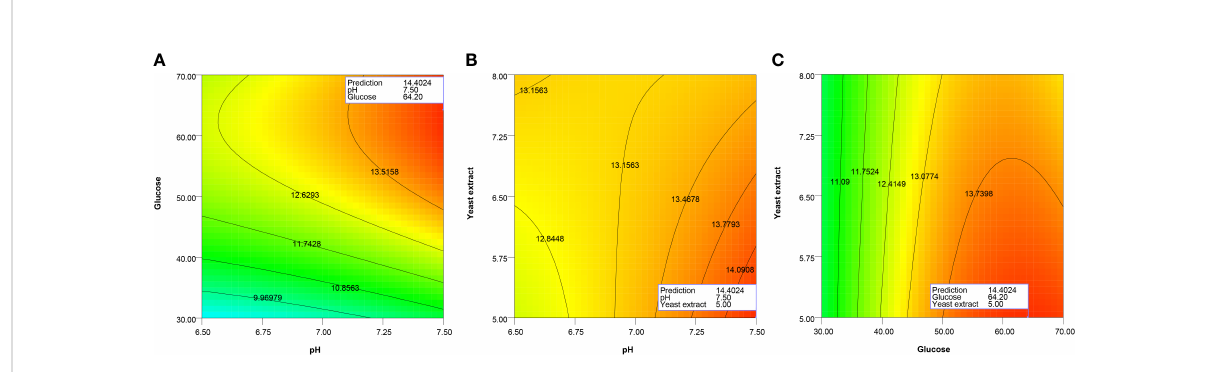
FIGURE 3 Contour plots showing interactions effects between initial pH and initial glucose concentration (A) , initial pH and initial yeast extract concentration (B) , and initial glucose and yeast extract concentration (C) on growth of A. limacinum